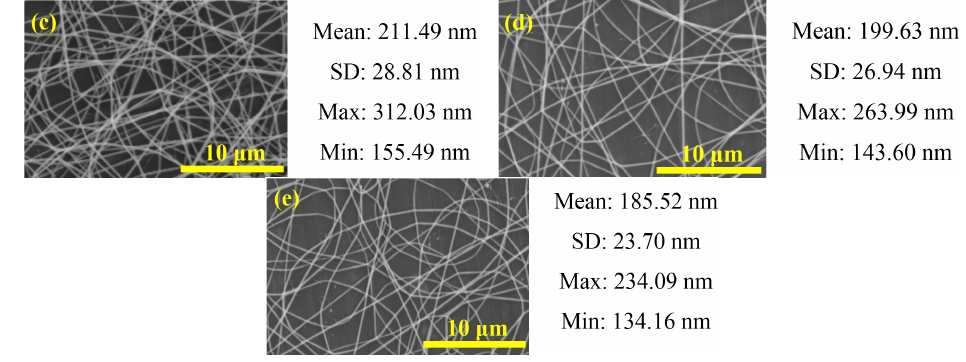
Figure 5. SEM images of PbI 2 /PVP composite fibers produced at different applied voltages: